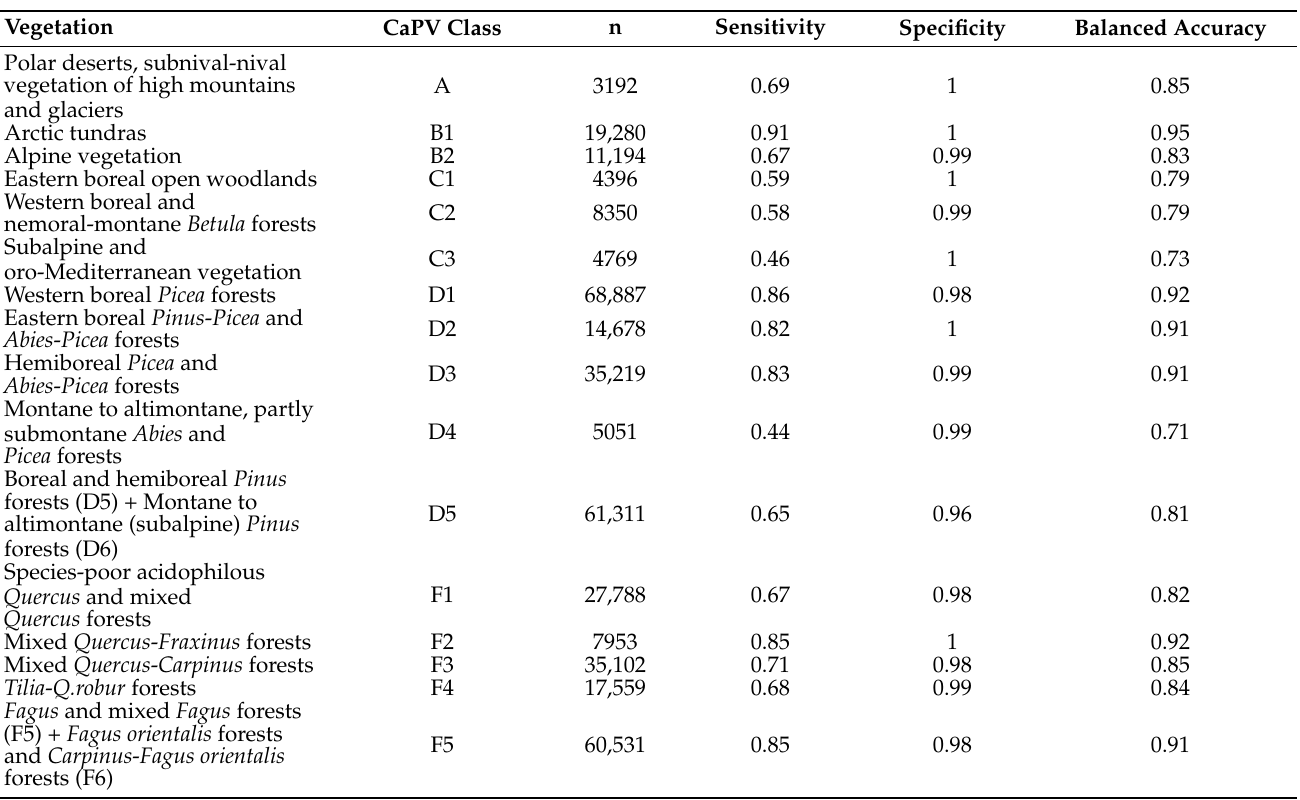
Table 1. Vegetation class specification (Vegetation), class designation (CaPV class), the number of observations of the class in the dataset (n) and the model performance measures calculated using test data (Sensitivity), (Specificity) and (Balanced